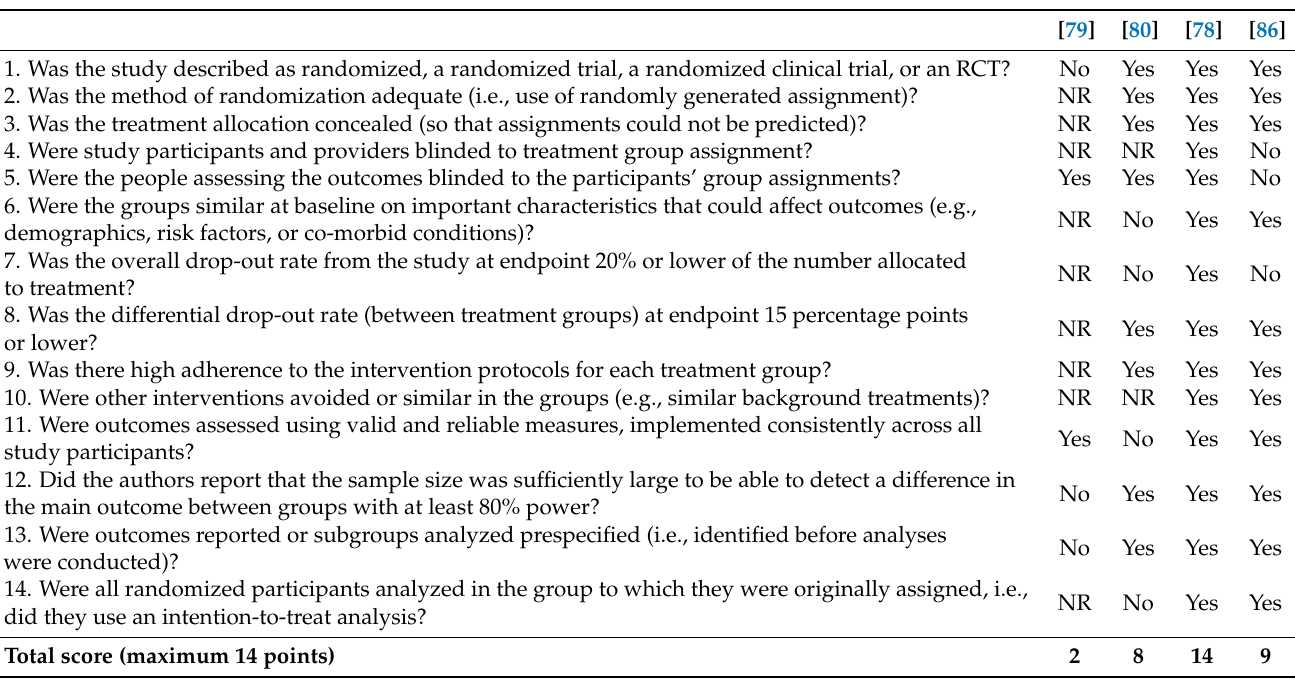
Table 6. Quality assessment of Controlled Intervention